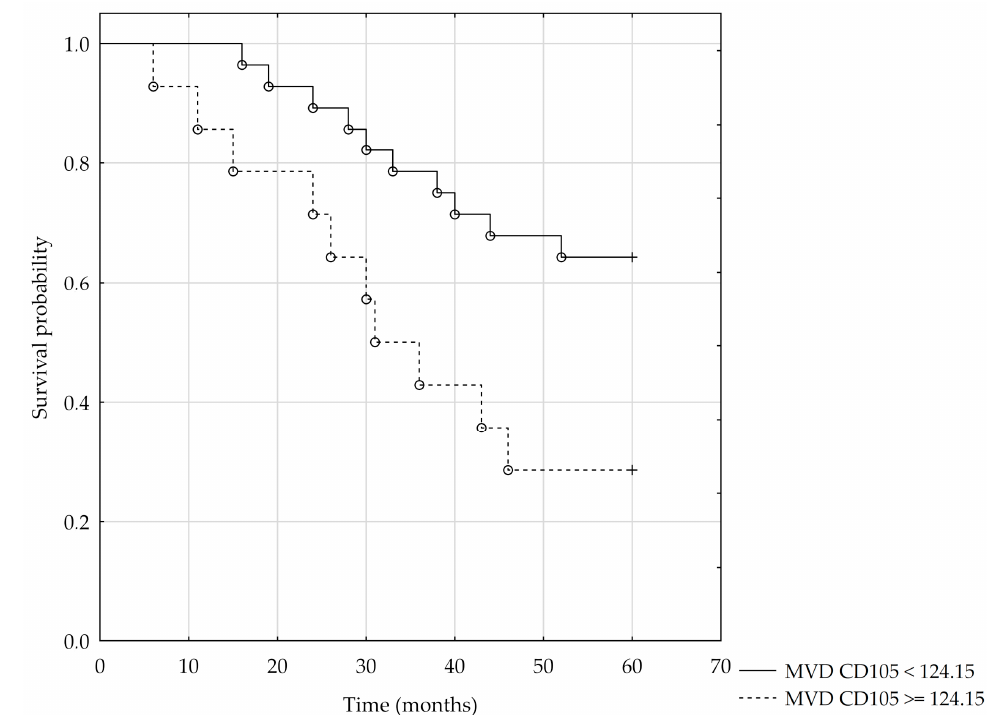
Figure 6. Kaplan–Meier analysis of the 5-year overall survival using the cut-off value = 124.15 for the